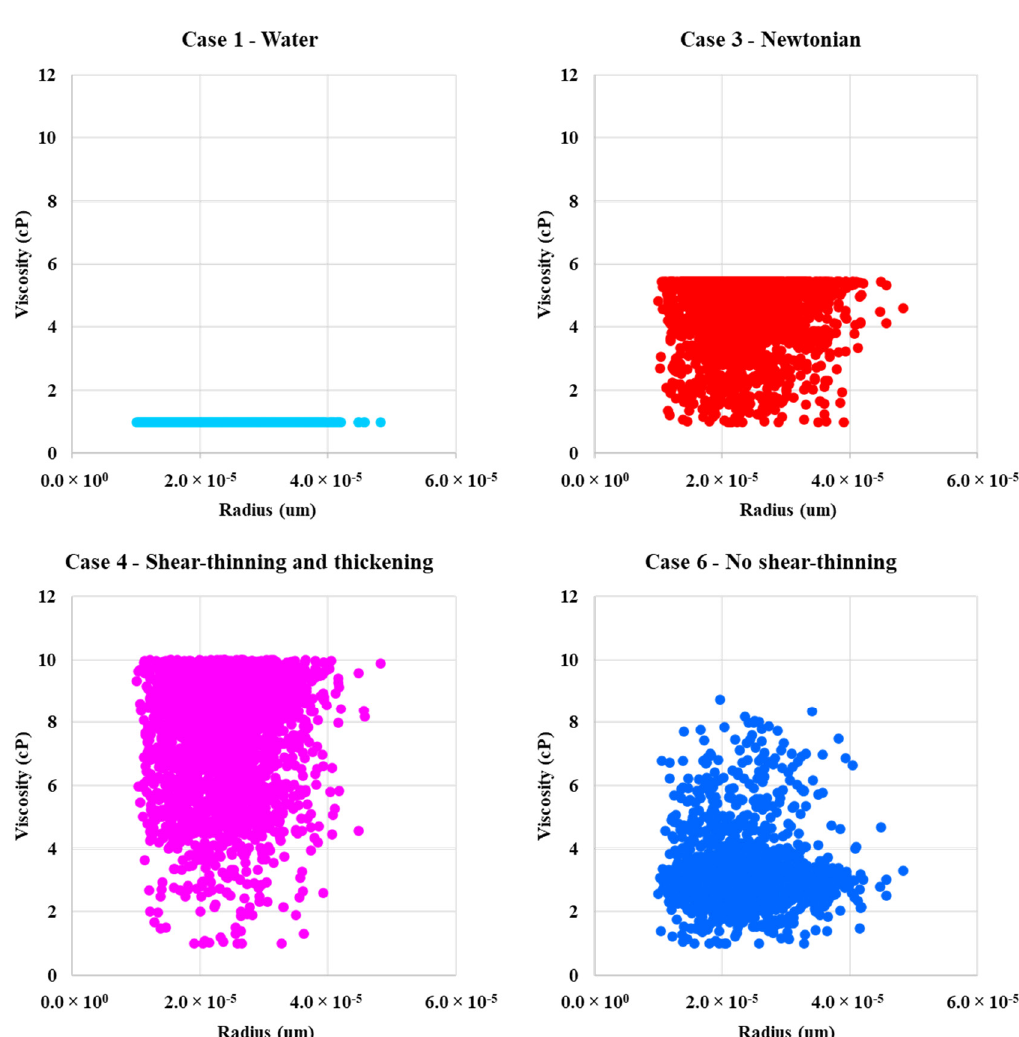
Figure 17. In-situ viscosity as a function of radius for Case 1—water, Case 3—Newtonian, Case 4—shear-thinning, and Case 6—thickening and no shear-thinning.